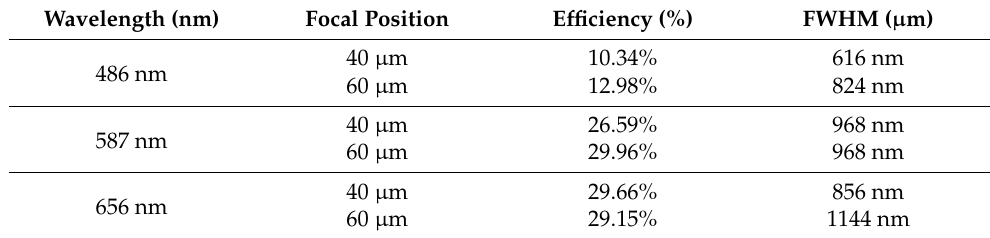
Table 1. Focal position, efficiency, and FWHM of